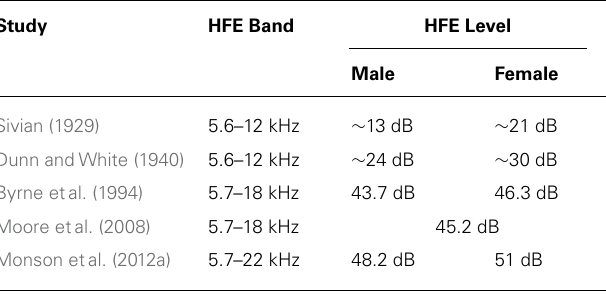
Table 1 | High-frequency energy (HFE) levels reported from five separate studies when the overall level is scaled to be 65 dB